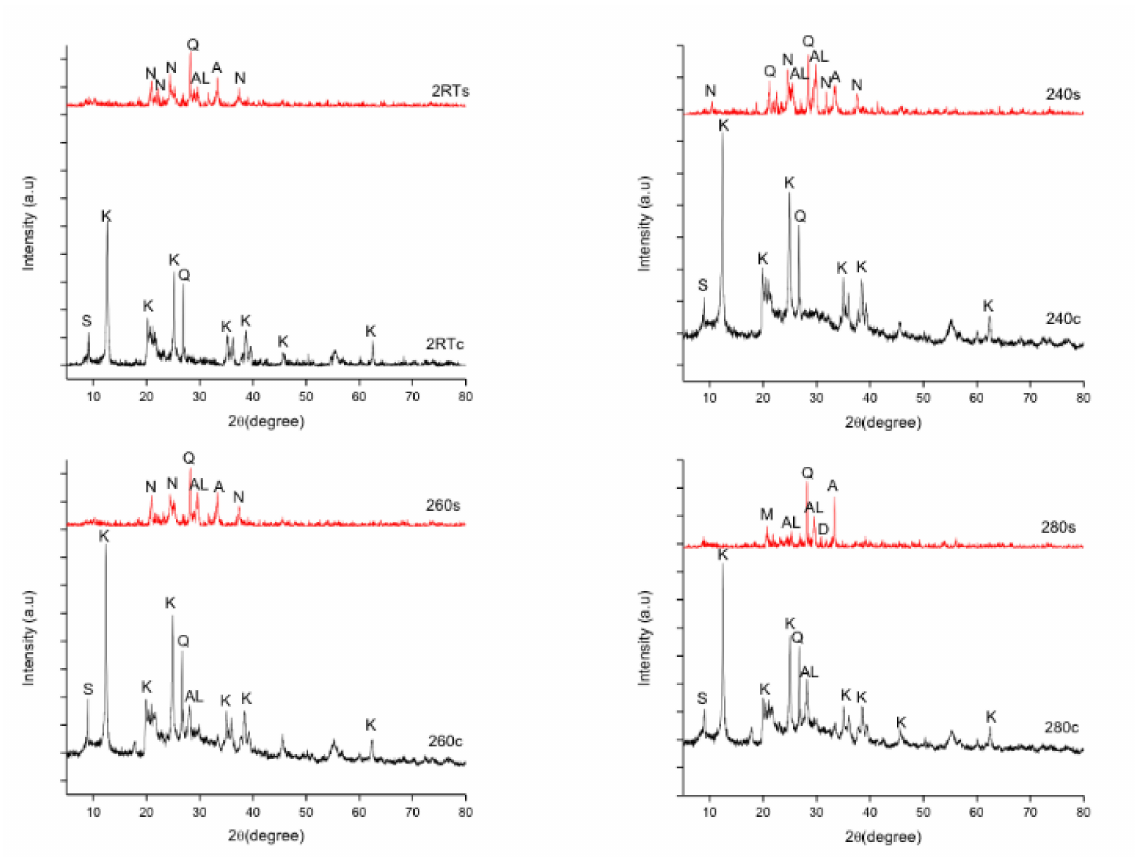
Figure 5. Phase composition of the as-cured and sintered kaolin-GGBS geopolymer. The degree of crystallinity of quartz (SiO 2 ) from GGBS at 20 to 28 ◦ had increased after 14 days of curing, indicating the reaction between kaolin and GGBS during geopolymeriza- tion. The addition of GGBS, with its disordered structure, had accelerated the combination reactions, leading to the formation of the geopolymer. When kaolinite is heated, the ad- sorbed water is liberated at above 100 ◦ C, and the weakest part of the chemical bond is broken. Then, dehydroxylation takes place at 450–600 ◦ C. For kaolinite, dehydroxylation might result in the disturbance of the Al(O,OH) 6 octahedral sheet by the outer hydroxyl groups, but does not have much effect on the SiO 4 tetrahedral sheet due to the more stable inner hydroxyl